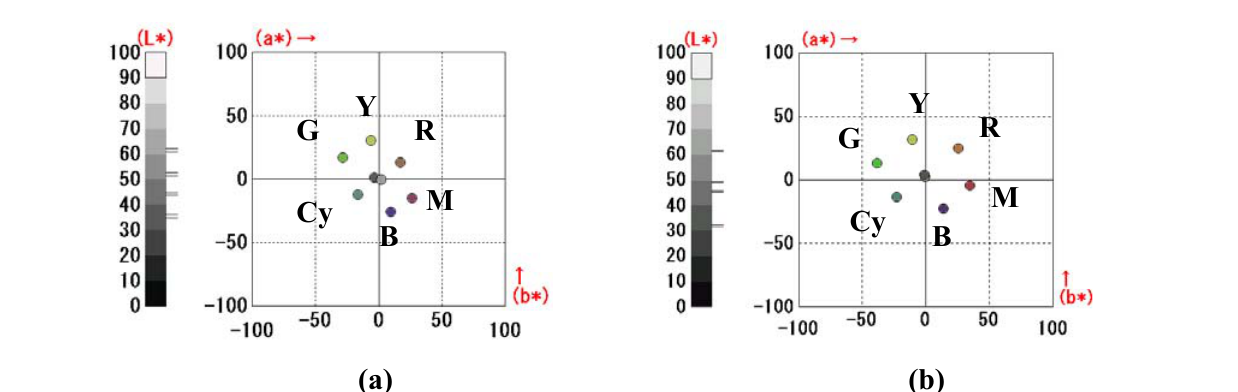
Figure 21. The calculated effects of active dichroic ratios on the volume of color